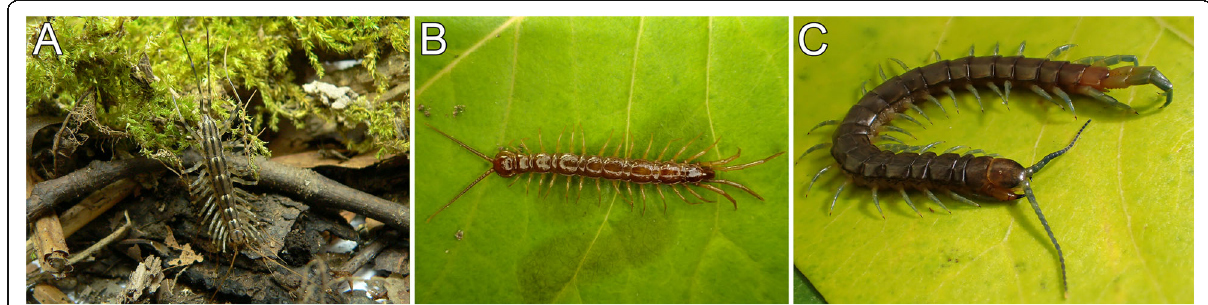
Fig. 1 The three centipede species investigated. a Scutigera coleoptrata. b Lithobius forficatus. c Scolopendra oraniensis.